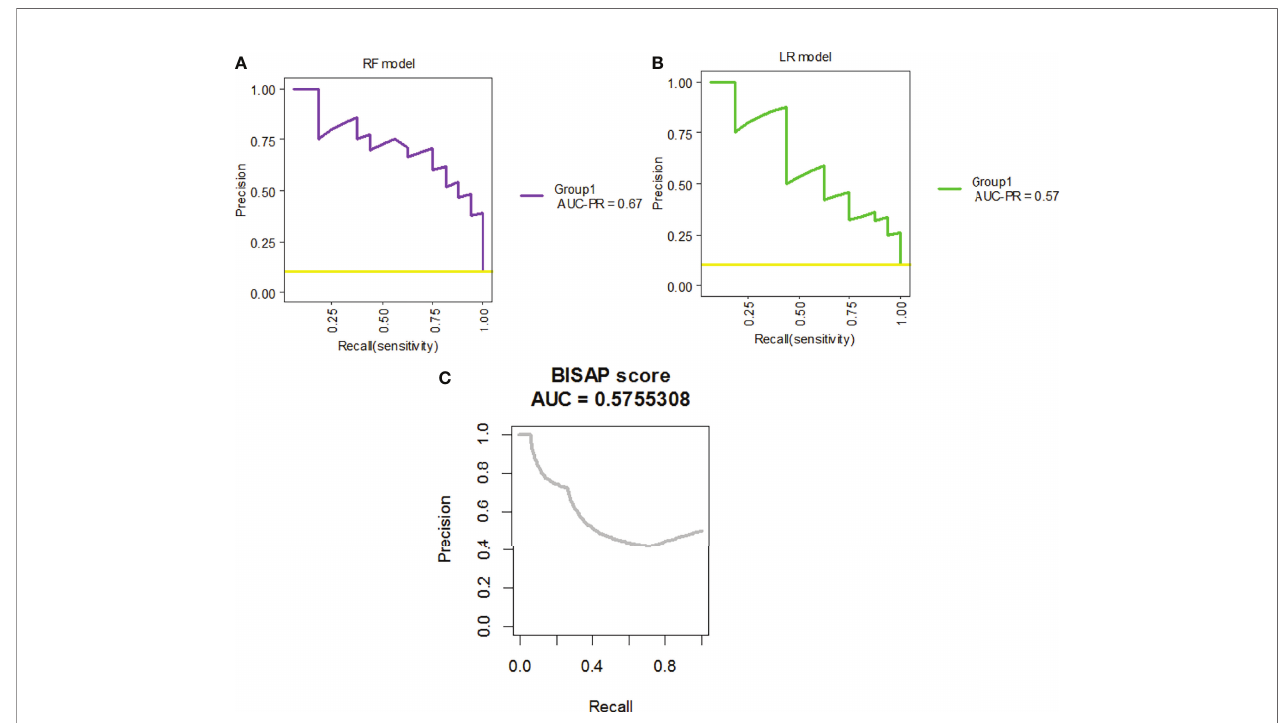
FIGURE 7 | The precision-recall curves for the (A) RF model, (B) LR model, and (C) BISAP score applied on the test